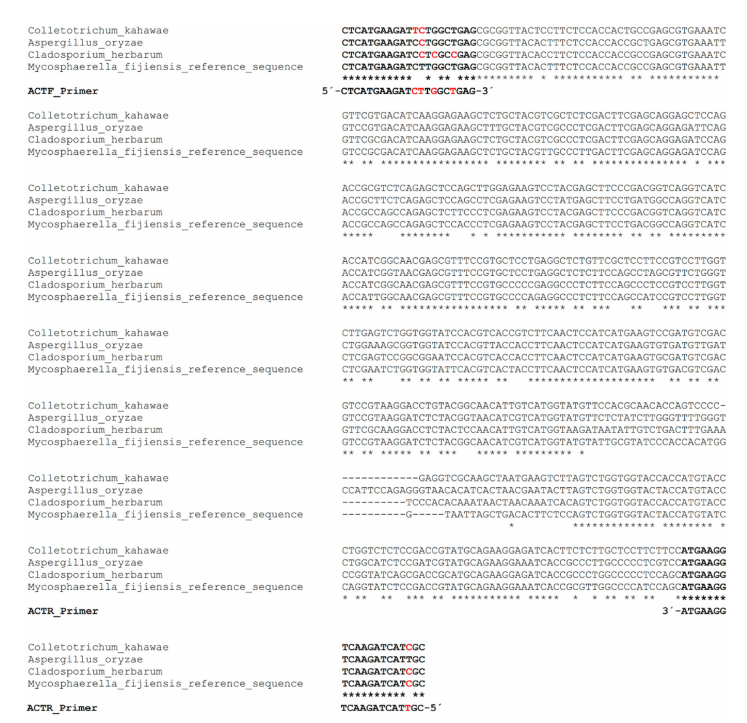
Figure 3. Nucleotide alignment of actin gene (partial sequences) from di ff erent fungi, amplified